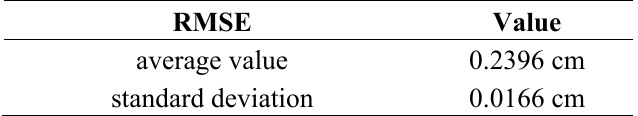
Table 4. The error distribution of SEMT in the second layout